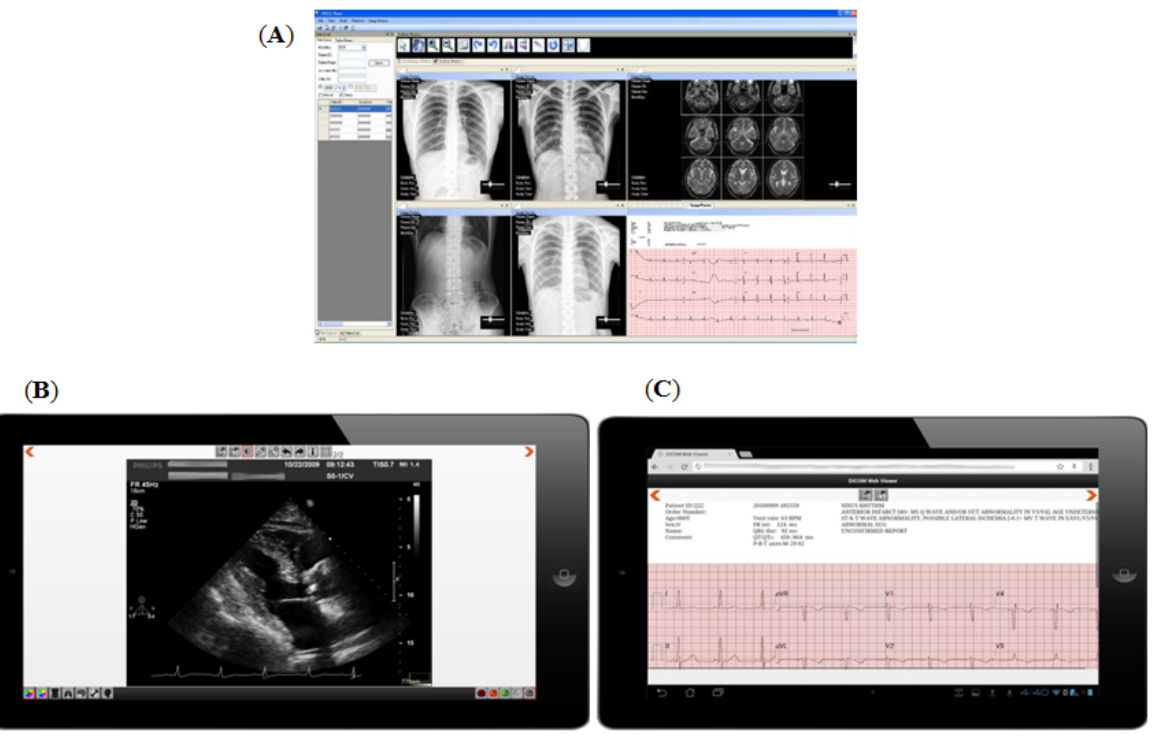
Figure 2. ( A ) Shows the manipulation of 12-lead ECG, X-ray chest, and MRI on a clinically-used PACS. ( B ) Shows a captured ultrasound image in an ECHO study using PACS via 3G telecommunication on a tablet. ( C ) Shows a display of 12-lead ECG through the access of PACS via 3G telecommunication on a